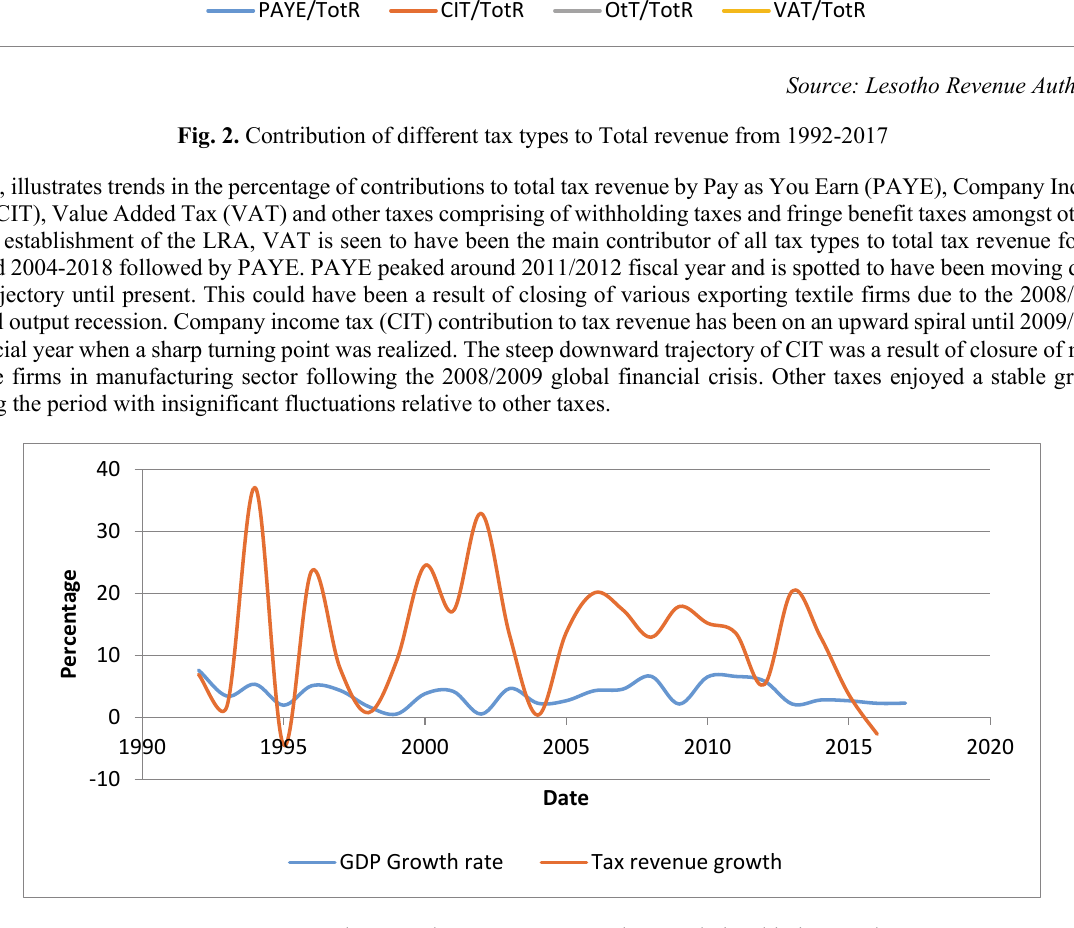
Fig. 3. GDP growth rate and Tax revenue growth rate relationship in Lesotho Source: Central Bank of Lesotho and Lesotho Revenue